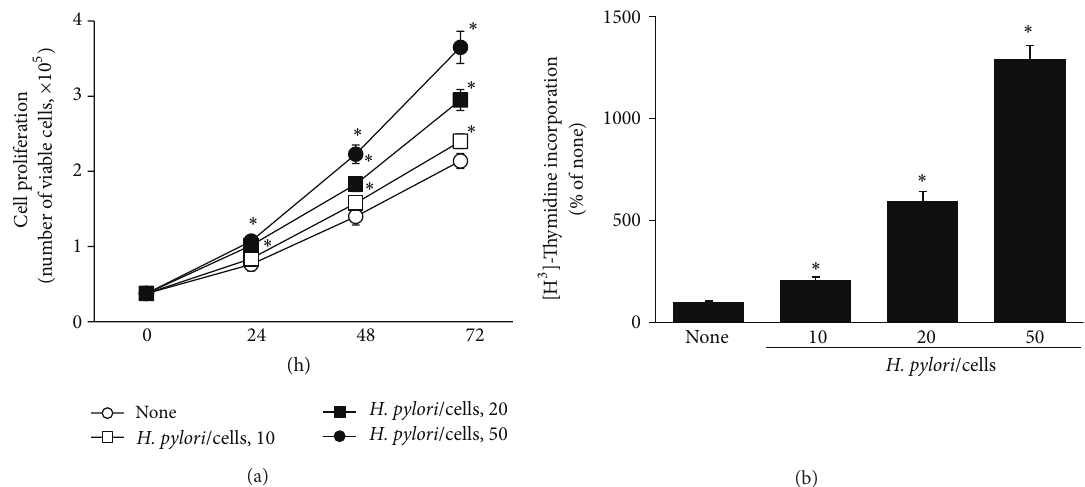
Figure 1: Cell proliferation of AGS cells infected with H. pylori. AGS cells were cultured in the presence or absence of H. pylori (at bacterium/cell ratio of 10, 20, 50: 1). Cell proliferation was assessed by viable cell numbers and [ 3 H ] thymidine incorporation. (a) Viable cell numbers were determined by trypan blue exclusion assay at the indicated time period. (b) The cells were treated with [ 3 H ] thymidine at 24 h after H. pylori infection and incubated for 8 h. The amount of [ 3 H ] thymidine incorporation of AGS cells cultured in the absence of H. pylori is considered as 100%. ∗ 𝑃 < 0.05 versus corresponding none (the cells cultured in the absence of H. pylori ).